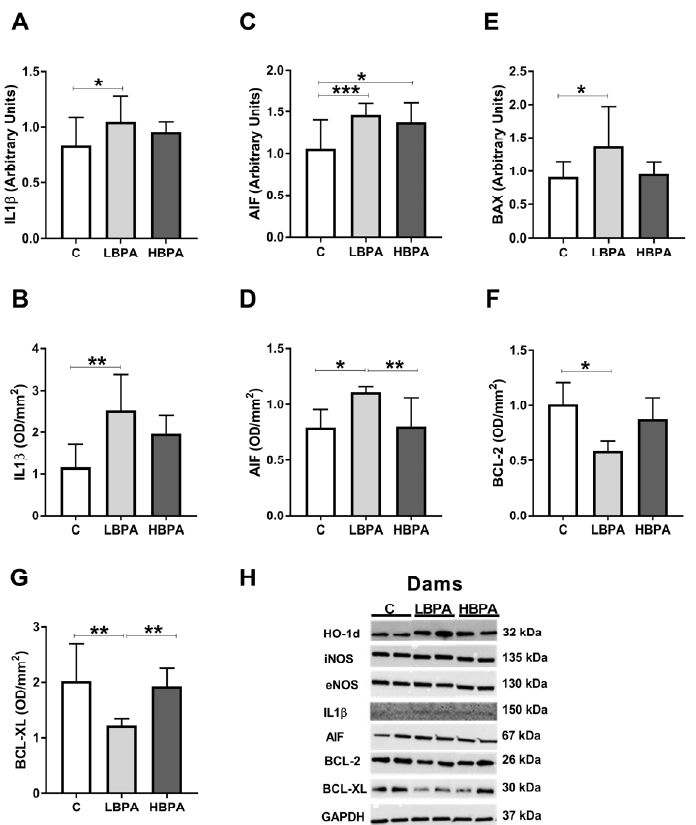
Figure 5. Inflammatory mediator and apoptosis markers in livers from lactating dams after exposure to different doses of BPA. mRNA and protein expressions of IL1 β (interleukin-1- β ) ( A , B ); mRNA and protein expression of AIF (apoptosis-inducing factor) ( C , D ). ( E ) mRNA expression of BAX (Bcl-2-associated X protein). ( F , G ) Protein expressions of BCL-2 (B-cell lymphoma) and BCL-XL (B-cell lymphoma-extra large). ( H ) Representative images of the Western blot results of the different proteins studied. Data represent mean ± SD. For mRNA, n = 8 control dams; n = 8 LBPA dams; n = 6 HBPA dams (three replicates for each gene). For protein, n = 5 rats per experimental group. Statistical significance was determined by one-way ANOVA. * p < 0.05; ** p < 0.01; *** p < 0.001.